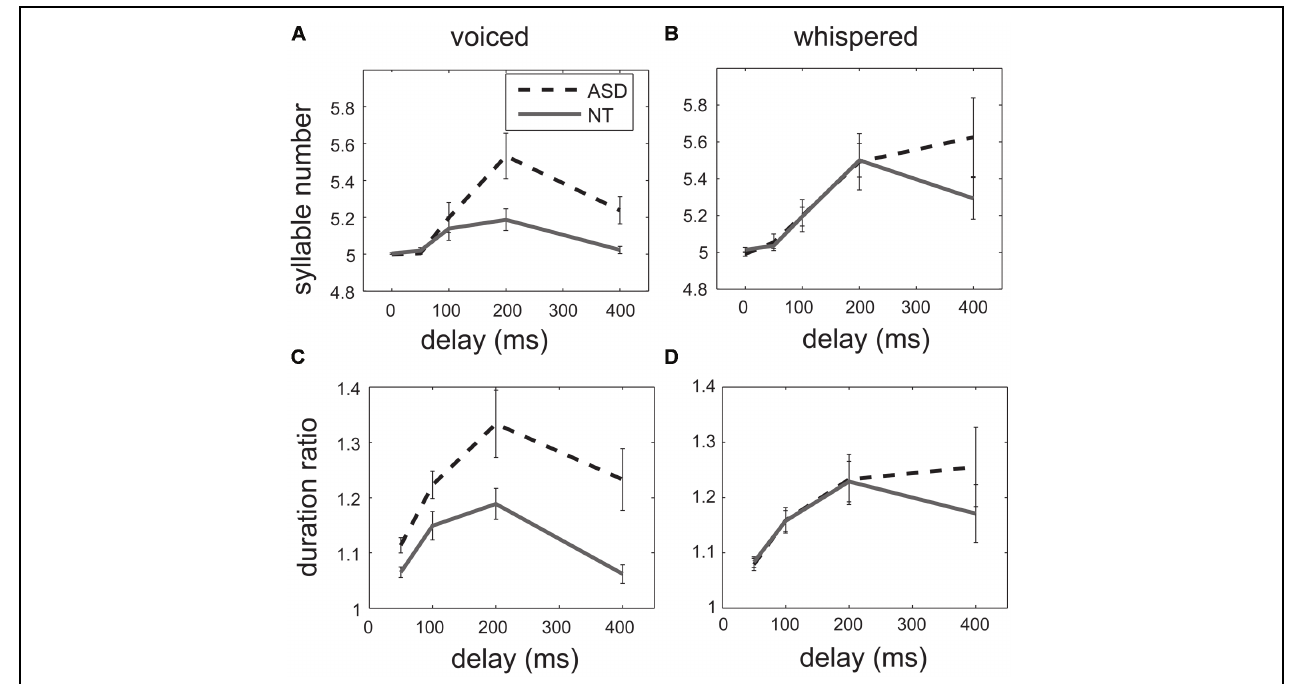
FIGURE 1 | The effect of the delay of auditory feedback on syllable number (above) and duration ratio (below) in two groups in the voiced delayed auditory feedback (DAF) experiment (A,C) and in the whispered DAF experiment (B,D). While the delay increased up to 200 ms, the syllable number and the duration ratio increased in both groups, indicated as mean ± standard error. For the voiced DAF experiment, the syllable number and the duration ratio increased more in the ASD group (black dashed lines) than in the control group (gray solid lines), but there was no such difference for the whispered DAF